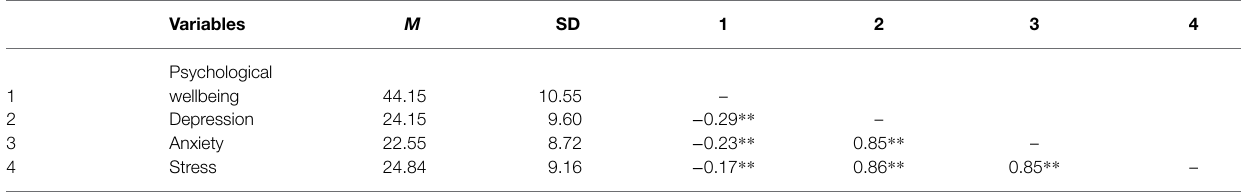
TABLE 3 | Descriptive statistics and correlations among the key variables. Variables